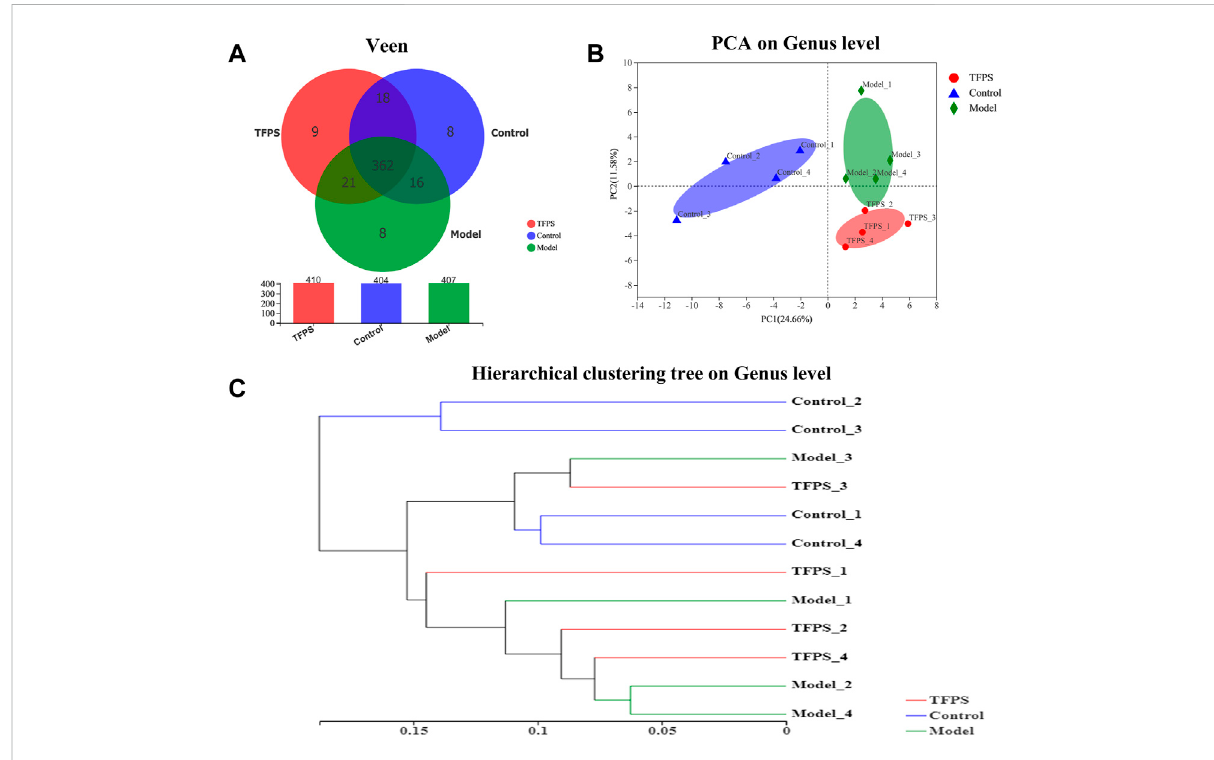
FIGURE 6 TFPS relieves DNFB-induced microbiota changes in AD-like mice. (A) Venn diagrams of OTUs. (B) PCA plot with unweighted UniFrac. (C) UPGMA clustering results based on unweighted UniFrac distance of microbial 16S rRNA sequences from animal feces samples.